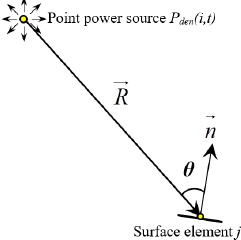
Figure 3. Schematic of the point power source where the cavity collapse takes place and its path to the point on the hydrofoil surface that will be loaded by the emitted power. Then, the power reaching position j on the surface of the hydrofoil at instant t , P imp ( j , t ), can be calculated